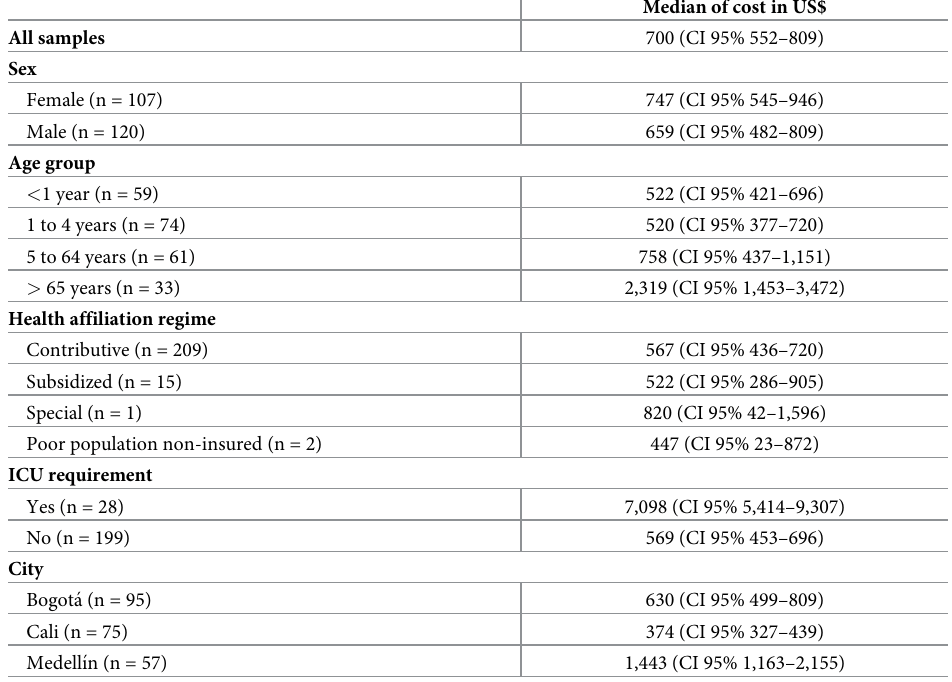
Table 2. Median direct medical cost per influenza SARI patients in Colombia, according to different disaggregation.